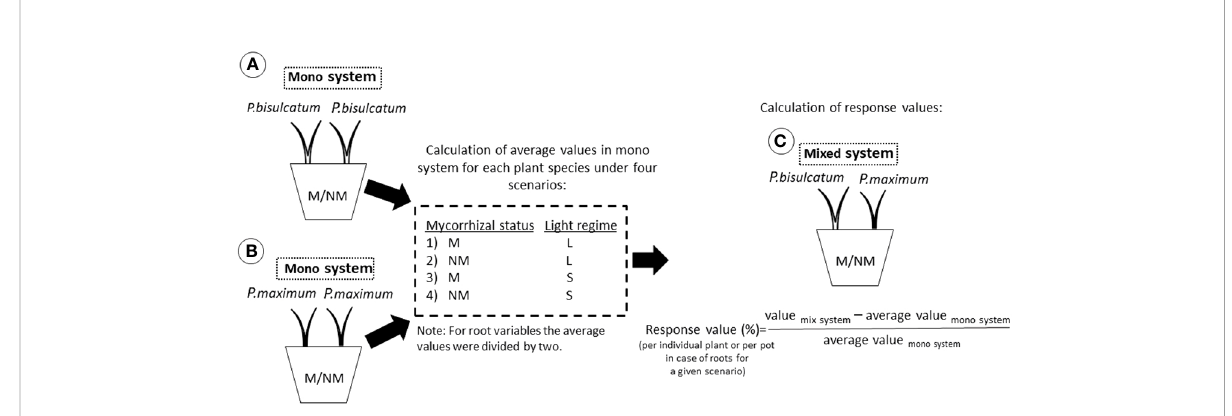
FIGURE 3 Schematic representation of the plant response model used to quantify the responses of two plant species in mixed culture compared to monoculture. (A) refers to a situation where two P.bisulcatum plants are grown together in a mono system. (B) refers to a situation in which two P.maximum plants are grown together in a mono system. (C) refers to a situation in which P.bisulcatum and P.maximum are grown together in mixed system. The average values for the different plants, measured in the relevant mono system, were calculated for four different scenarios: “ ML ” , “ NML ” , “ MS ” , and “ NMS ” , taking values for individual shoots and half of values for roots as data for a single plant in mono system pots. “ M ” and “ NM ” refer to mycorrhizal and non-mycorrhizal status, respectively. “ L ” and “ S ” refer to a condition where the co-cultivated plants are in full light and full shade, respectively. Response values per individual plant for a given scenario were then calculated to express percent change in the mixed system compared to the relevant mono